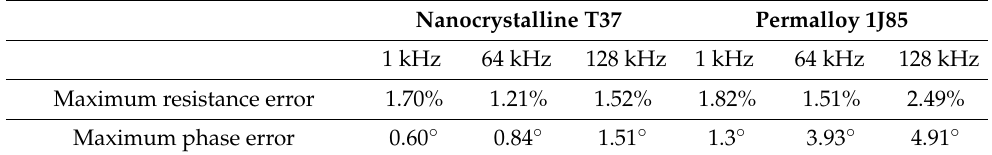
Figures 5 and 6 show the impedance error and the phase error of different sensors at different frequencies. In general, the phase angle error of nanocrystalline T37 was smaller and fluctuates less than that of Permalloy 1J85, especially at high frequencies. The phase error is proportional to the magnetic loss. The phase error at individual points is due to large parasitic capacitance or inductance by accidental factors during the production of standard resistors. In addition, the higher the frequency of the measured signal, the larger the detected phase angle error. The main reason for this is that, the higher the frequency, the fewer sampling points in a signal cycle. After the comprehensive comparison of test results, the frequency range of NCACII was determined to be 1–100 kHz.